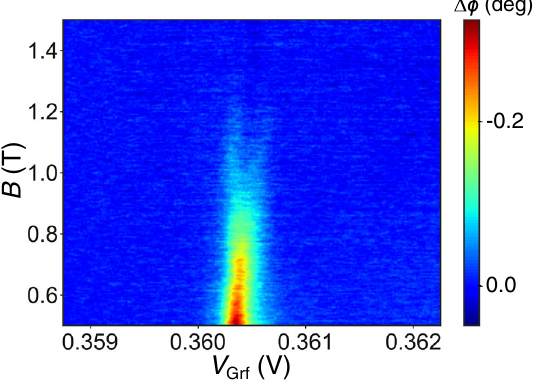
FIG. 6. Dispersive measurement of the (1,15)-(2,14) interdot ¼ 0 . 440 V as a function of external in- charge transition at V Gmw plane magnetic field from B ¼ 0 . 5 T to 1.5 T. In the B ¼ 0 . 9 T to 1.2 T region, a double peak arising from the tunneling between (cid:4) triplet states, T − and T − , is